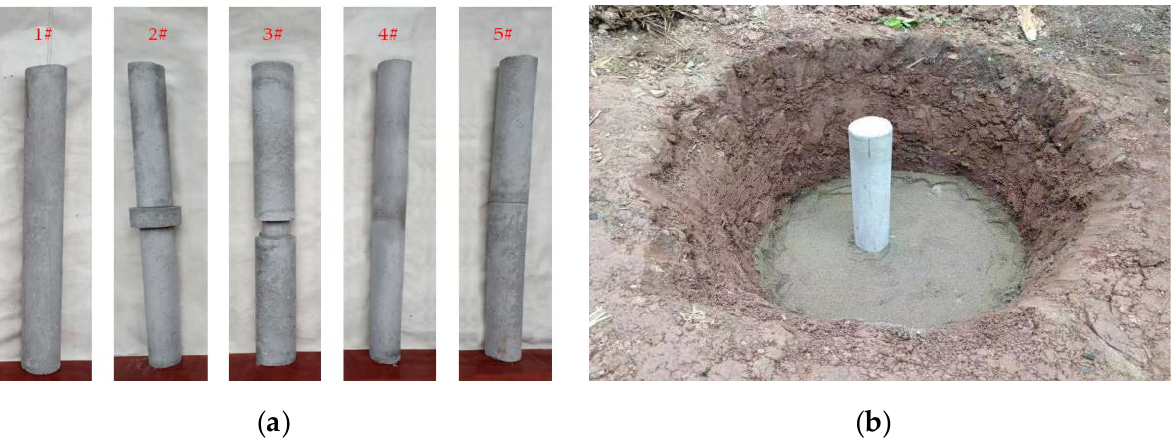
Figure 7. Pile models: ( a ) 1# complete pile, 2# diameter expanding pile, 3# diameter shrinkage pile, 4# segregation pile, and 5# broken pile; ( b ) Placement of model pile.